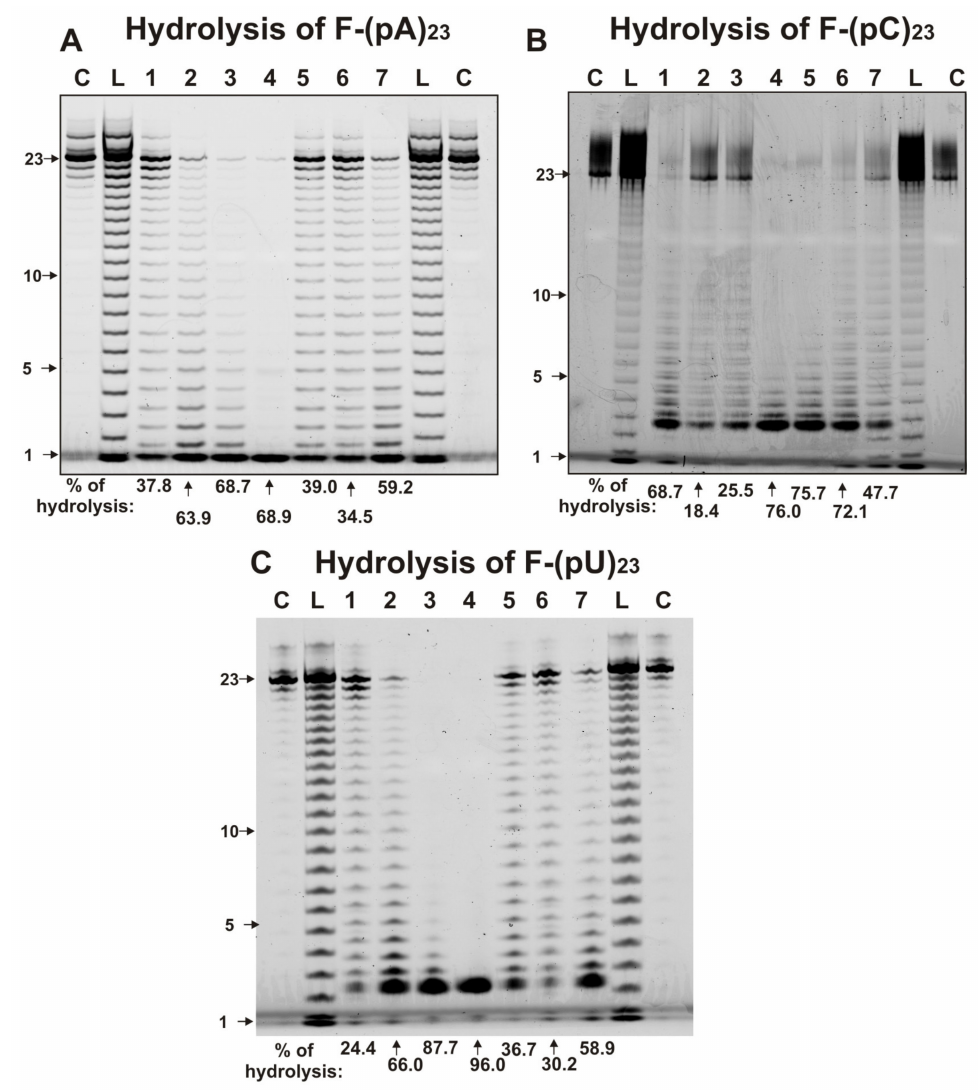
Figure 2. The patterns of F-ribo-ONs (0.01 mg / mL) splitting by seven individual milk IgGs (40 µ g / mL). The products of the hydrolysis were revealed after mixture incubation for 1 h and subsequent 20% PAGE electrophoresis; the relative fluorescence (%) of intact substrates and the products of their hydrolysis was estimated. The numbers of IgGs, lengths of the products, and percentage of ribo-ONs hydrolysis by each IgG preparation are indicated in panels A–C . L lanes correspond to the markers of ONs lengths, while C lanes correspond to the substrates incubated without IgGs. The percentages of ONs hydrolysis correspond to the average values of three independent